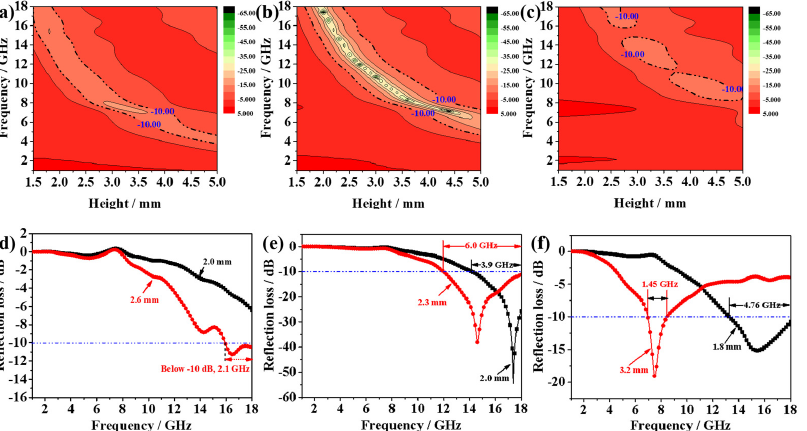
Figure 7. Color map of the reflection loss values and effective absorption bandwidth CoS 2 /paraffin composites with different CoS 2 proportions at different thicknesses: (a,d) 10 wt%, (b,e) 20 wt%, (c,f) 30 wt%. (The area enclosed by the dotted lines represents the area of effective absorption below— 10 dB)